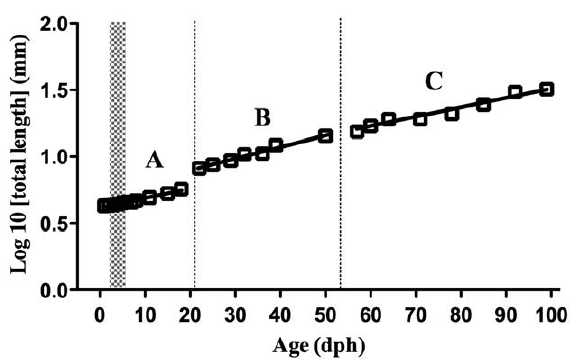
Fig. 4. – A, mean total length data of growth in larvae and juveniles of Chelon labrosus as a function of age from 1 to 99 dph. Data are plotted on a logarithmic ordinate grid, and values are represented as mean ±S.E.M (n=10-30). Linear regression equations for each dis- tinct growth stage (bold lines) were estimated by the least-squares regression method using log-transformed data. Bar represents the moment of mouth opening (4 dph).